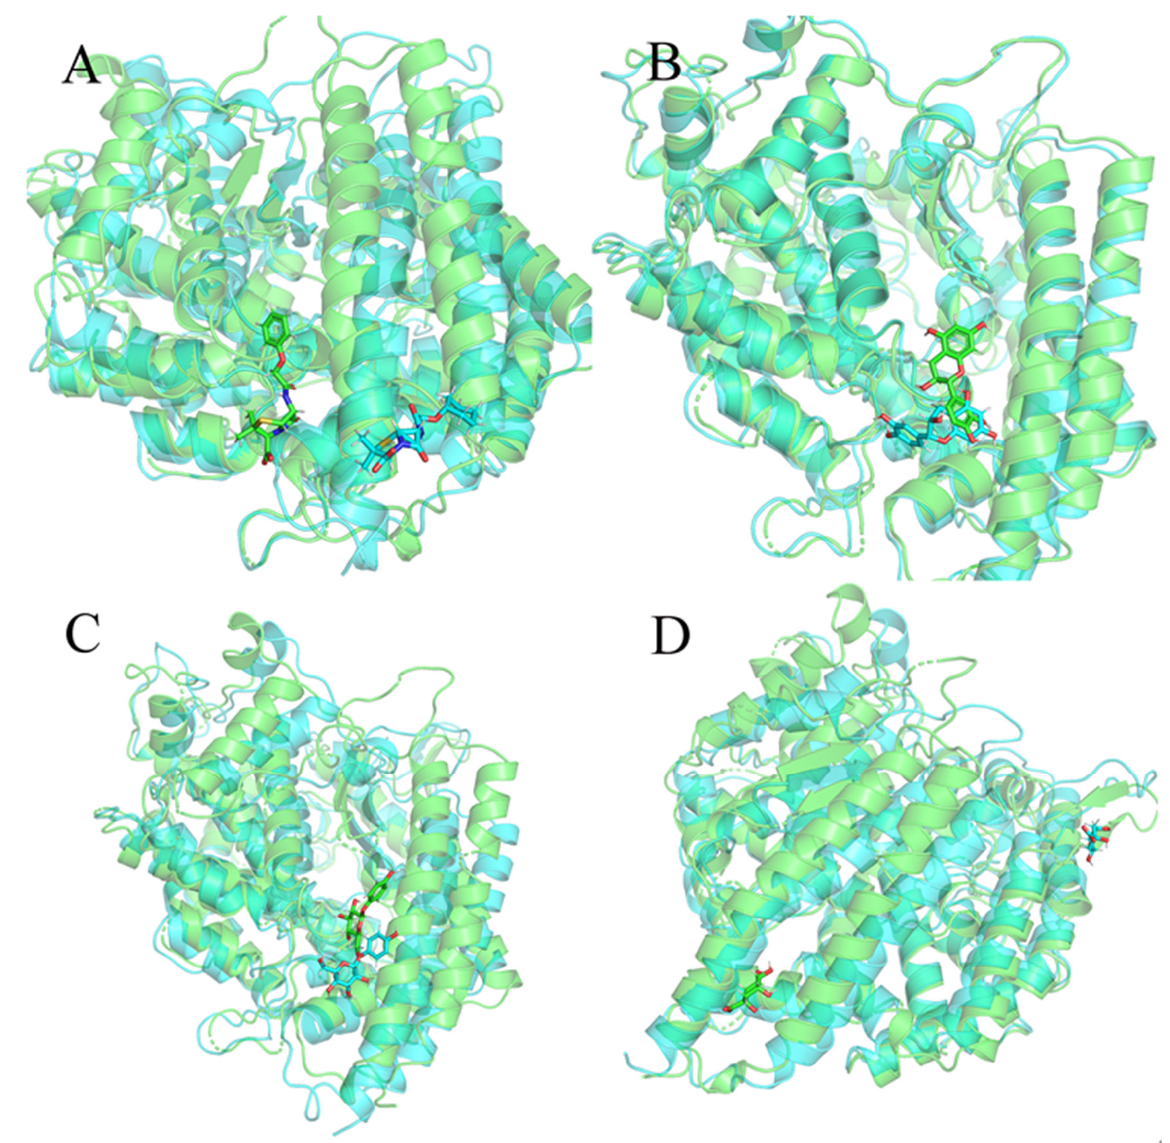
Figure 5. Overlay of the last frame structure of the trajectory and the initial structure. Green is the initial structure, and blue is the last frame structure from the trajectory. ( A ) 132-98-9/ACE2, ( B ) − 154-23-4/ACE2, ( C ) STOCK1N-07141/ACE2, and ( D ) STOCK1N − 53429/ACE2. ( B ) 154-23-4/ACE2, ( C ) STOCK1N-07141/ACE2, and ( D ) STOCK1N